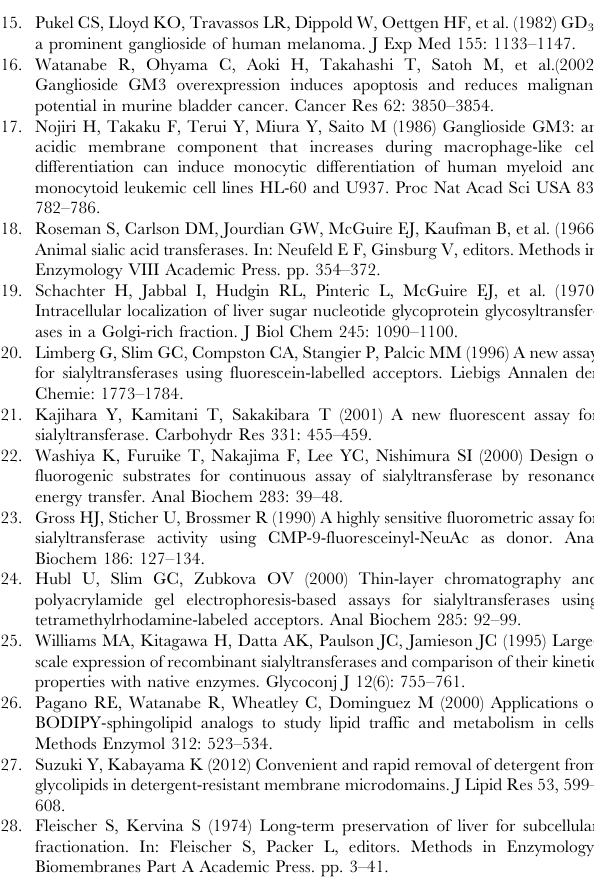
Figure S2 The TLC analysis of bovine microsomes Triton extracted samples. Lane 1: ganglioside standards (GM1, GD3 & GD1a); Lanes 2 & 3, calf liver microsomes Triton